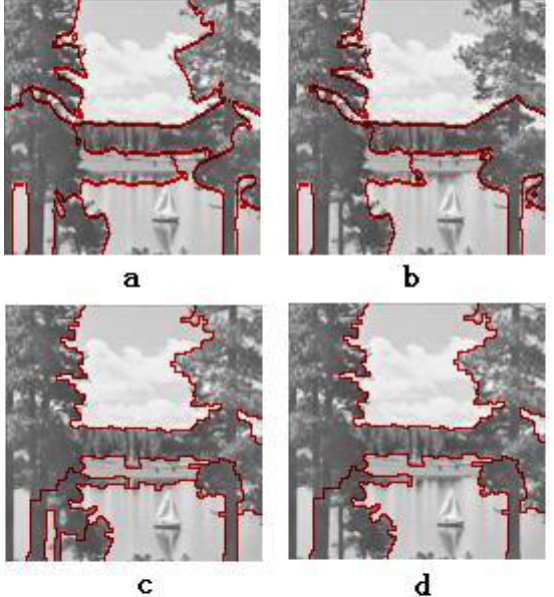
Fig 13 The comparison of segmentation of „Baboon‟ between our method (c, d) and Normalize Cut (a, b) algorithm. Figure a, c are 10 regions while figure b, d are 6